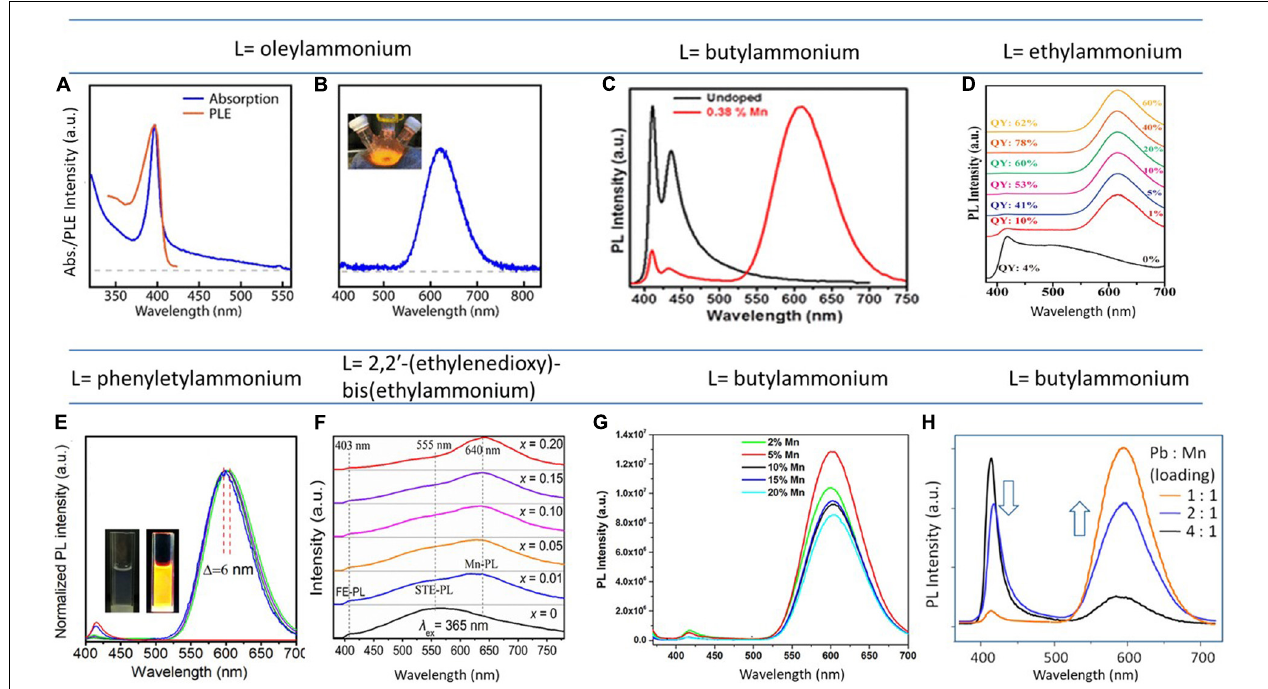
FIGURE 2 | (A) Absorbance, PLE, and (B) PL spectra of (oleylammonium) 2 PbBr 4 ; inset is showing the illuminated three-necked flask having orange emission. (C) The PL spectra of undoped (black) and Mn(II)-doped (red) butylammonium lead bromide single crystals. Mn concentration–dependent PL spectra of Mn-doped L2PbBr 4 , when the corresponding spacer ligand (L) is (D) phenylethylammonium, (E) ethylammonium, (F,G) butylammonium and (H) 2,2’-(ethylenedioxy)-bis(ethylammonium). (A,B) are adapted from Parobek et al. (2018), with permission from the American Chemical Society. (C) is adapted from Sheikh and Nag (2019), with permission from the American Chemical Society. (D–H) are reproduced from Biswas et al., 2017; Dutta S. K. et al., 2019; Luo et al., 2019; Sun et al., 2019; Zhou et al., 2019, with permission from the American Chemical